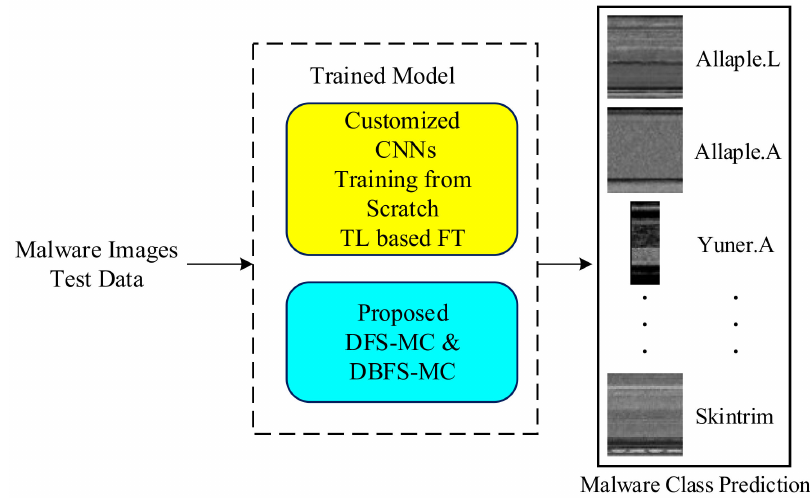
Figure 3. Testing phase of malware classification